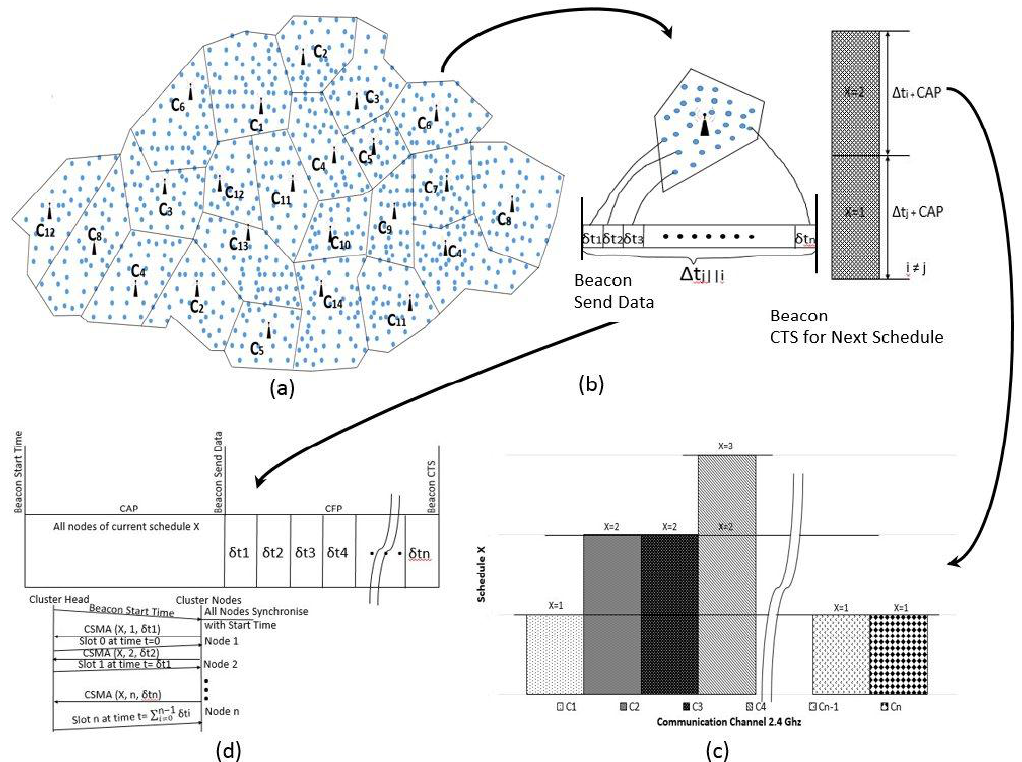
Figure 2. Functional Overview of the CMSP protocol: ( a ) Multi-Channel Voronoi Partition of a Dense Sensor Network; ( b ) Intra-Cluster Time Scheduling; ( c ) Inter-Cluster Same Channel Time Scheduling; ( d ) Intra-Cluster CAP signaling for assigning time slots to